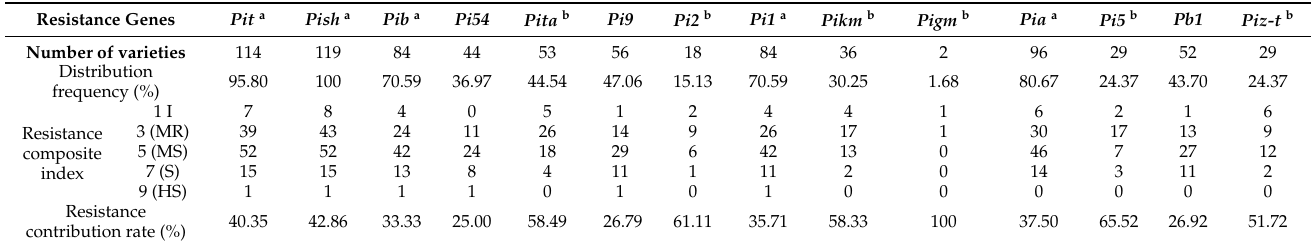
Table 2. The distribution frequency and resistance contribution rate of 14 R